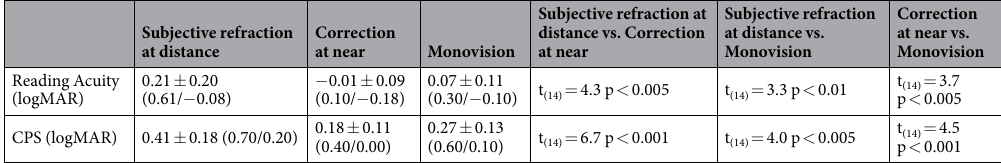
Table 2. First three columns: group means and SDs (with ranges in parentheses) for the binocular reading acuity and critical print size (CPS) in the Radner test in three conditions: subjective refraction at distance, correction at near (i.e., subjective refraction at distance plus the final addition at near), and monovision. Last three columns: results of the t-tests